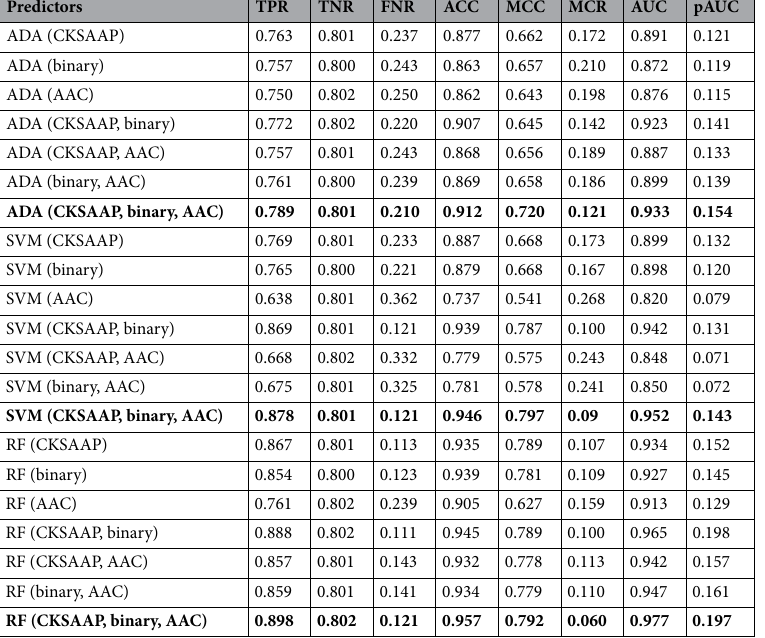
21 prediction models. The other group G1 was utilized to validate the trained models by computing TPR, TNR, FNR, ACC, MCR, MCC, ROC, AUC, and pAUC. At phase 2, four subgroups (G1, G3, G4 & G5) containing approximately 80% window samples were also used as before to train all prediction models. The other G2 group was used to compute the performance indicators (TPR, TNR, FNR, ACC, MCR, MCC, ROC, AUC, and pAUC) as before. In this case, only the subgroup pair G1–G2 interchanged their positions between the training and test sets. Similarly, subgroup pairs G2–G3, G3–G4, & G4–G5 exchanged, their positions between the training and test sets, respectively, at another three (3) loops. The performance scores of TPR, TNR, FNR, ACC, MCR, MCC, and pAUC were calculated by fixing the cutoff point at FPR = 0.20 for each of 5 loops. Then we computed the average performance scores of TPR, TNR, FNR, ACC, MCR, MCC, ROC, AUC, and pAUC and displayed the summary results in Table 2. The values in the first bracket represent the standard error (SE) of performance scores. As before, at first, we investigated the performance of ADA based 7 prediction models. We observed that 3 encodings (Binary, CKSAAP, AAC) based fusion model produces largest average scores of TPR (0.654), TNR (0.801), ACC (0.721), MCC (0.456), AUC (0.799) and pAUC (0.1404), and smallest scores of FNR (0.346) and MCR (0.287). Thus ADA based fusion prediction model with 3 encoding schemes showed better performance compare to the other 6 ADA based prediction modes (see Table 2 and Fig. 3A). Similarly, SVM and RF based fusion prediction models with 3 encoding schemes also showed better performance compared to their 6 alterna- tive prediction modes (see Table 2 and Fig. 3B,C). Then we compared the ADA, SVM, and RF based three best prediction models and observed that the fusion model RF(Binary, CKSAAP, AAC) produces the larger TPR (0.810), TNR (0.802), ACC (0.778), MCC (0.666), AUC (0.832) and pAUC (0.168) and the smaller FNR (0.190) and MCR (0141) compare to the ADA and SVM based best prediction models that were written as ADA(Binary, CKSAAP, AAC) and SVM(Binary, CKSAAP, AAC) as before (see Table 2 and Fig. 3D). That is, the proposed RF based prediction model RF (Binary, CKSAAP, AAC) performed much better compared to the other 20 predic- tion models by 5-fold CV with the training dataset corresponding to 1:2 ratio of positive and negative samples. Similarly, it showed better performance compared to both ADA and SVM based fusion models by 5-fold CV with the training datasets corresponding to 1:1 and 1:3 ratio cases also (see Figs. S3A and S4A in the Supple- mentary File S2). Again, we observed from Figs. 3D, S3A, and S4A that the proposed RF based fusion prediction model RF (Binary, CKSAAP, AAC) show slightly better performance for both 1:2 and 1:3 ratio cases compared to the 1:1 ratio of positive and negative samples. It was also observed that its performance is almost same for both 1:2 and 1:3 ratio cases. Thus, the RF-based fussing model with 3 encoding schemes (Binary, CKSAAP, AAC) showed better performance compared to the ADA and SVM based best prediction models by 5-fold CV also. Performance of prediction models with the independent test dataset. To evaluate the independ- ent test performance of the proposed prediction model compared to the other 20 candidate models, all candidate models were trained by the training dataset of 1:2 ratio of 3925 positive and 7850 negative window samples, as mentioned earlier in sections “Data preparation and overview on the development of the proposed predic- tion model” and “Performance of prediction models with the training dataset”. The independent test dataset